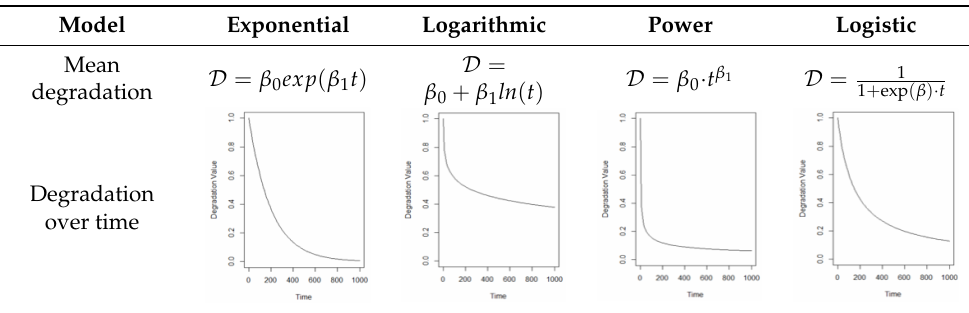
Degradation over